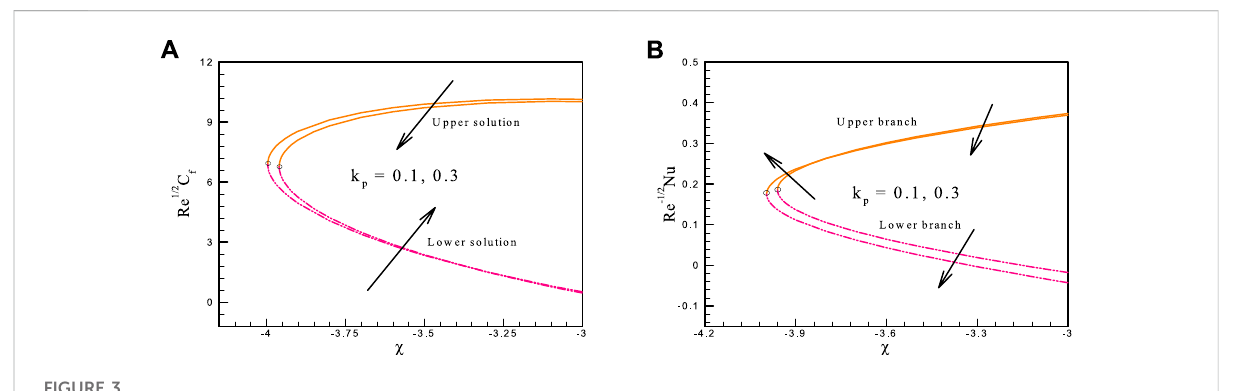
FIGURE 3 Interpretation of Re 1 2 C f and Re − 1 2 Nu for distant values of k p .